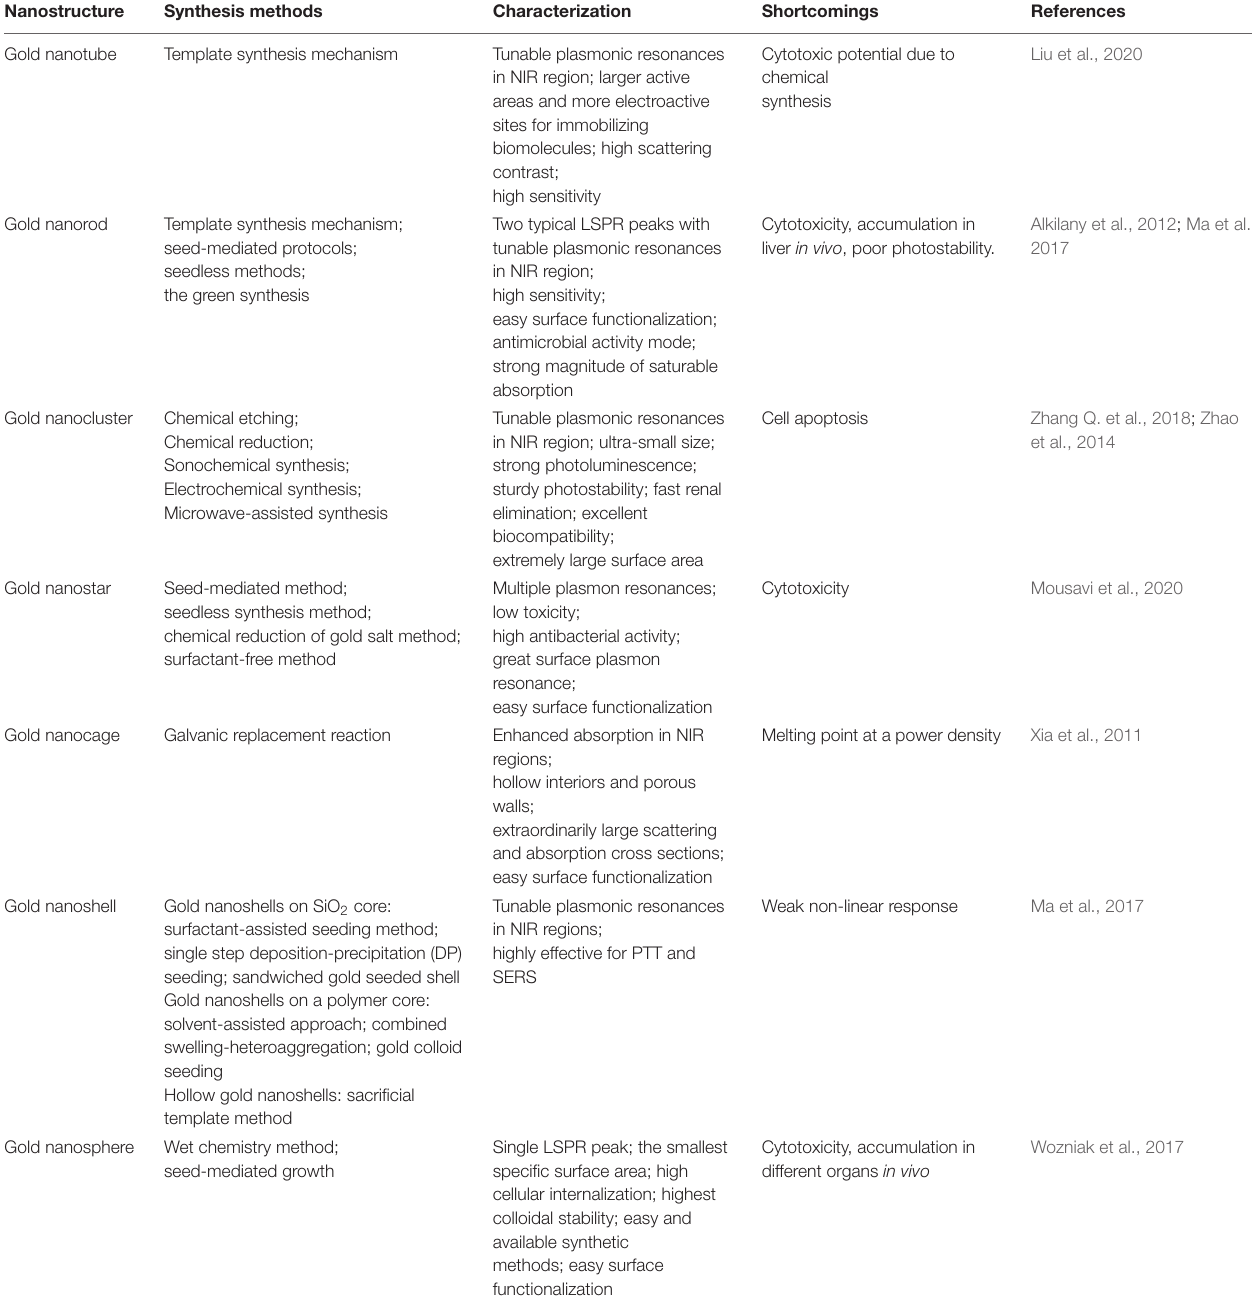
TABLE 1 | Summary of various gold